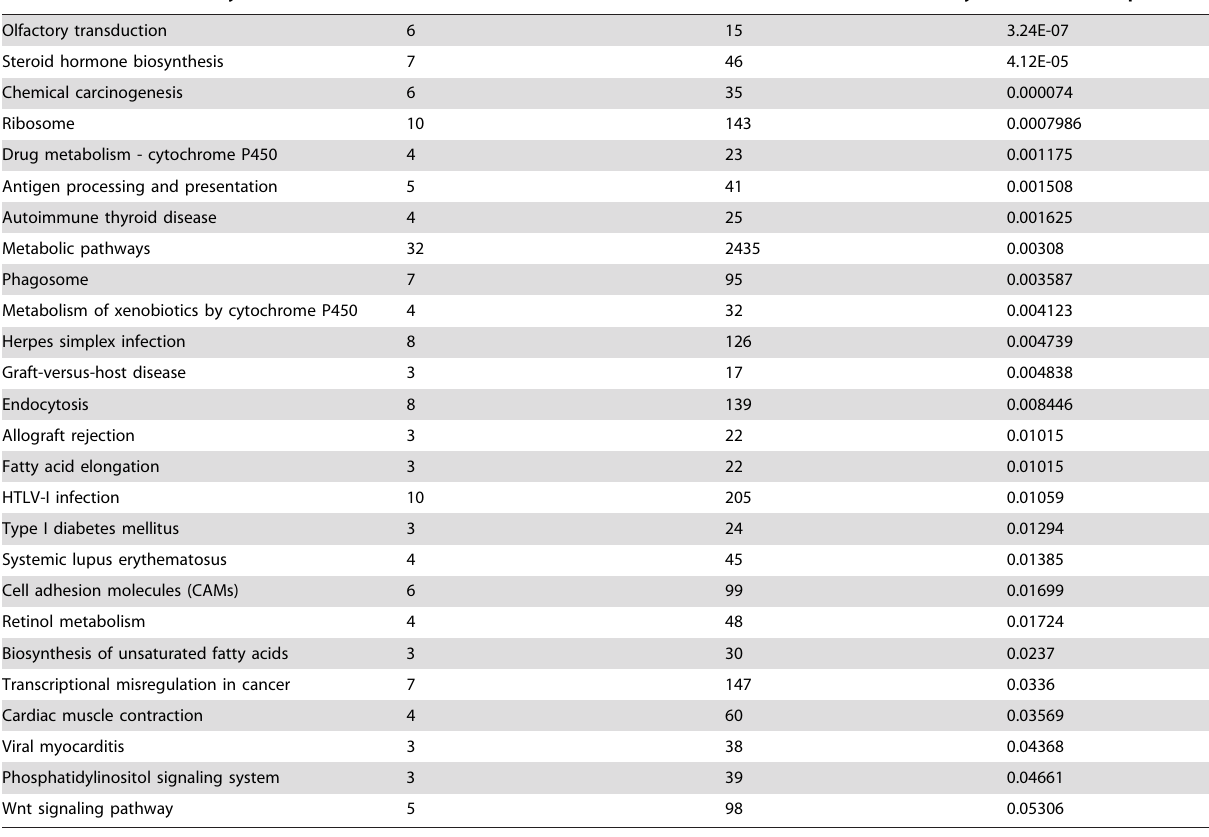
Table 2. Pathway DMR